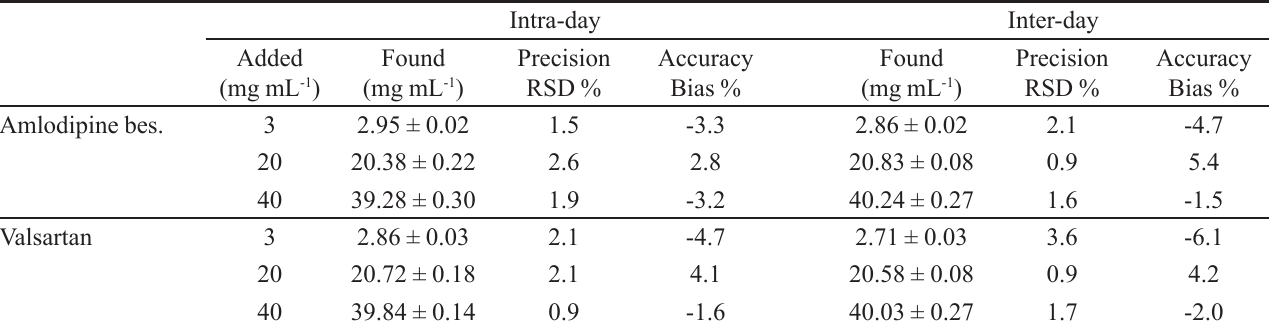
TABLE II - Precision and accuracy of the developed method